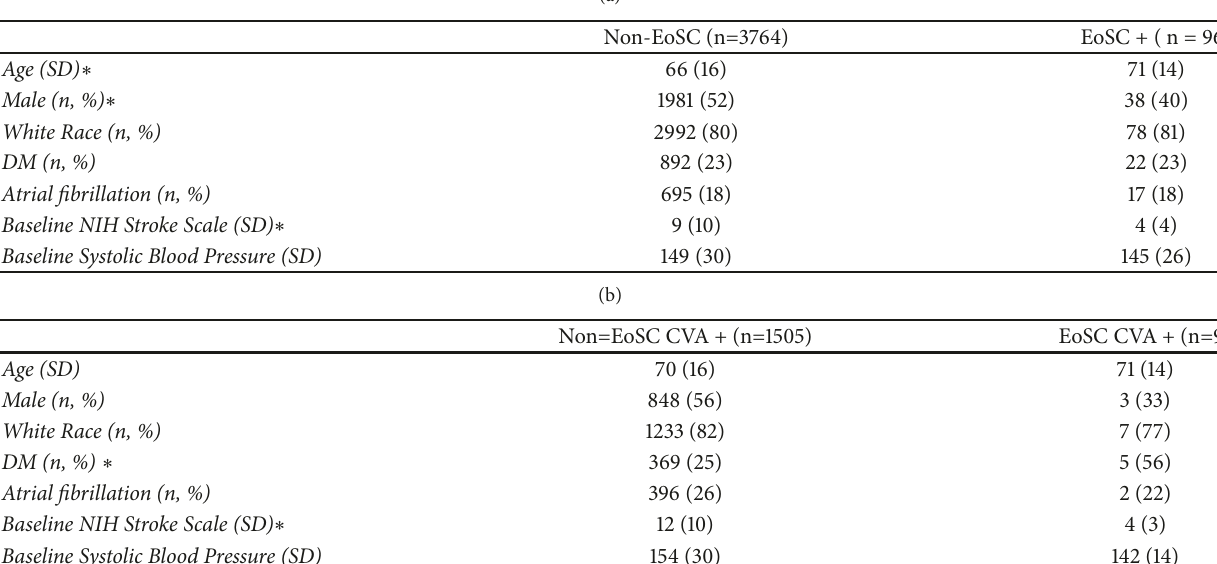
Table 2: Patient Demographics (EoSC & EoSC CVA+): Definition